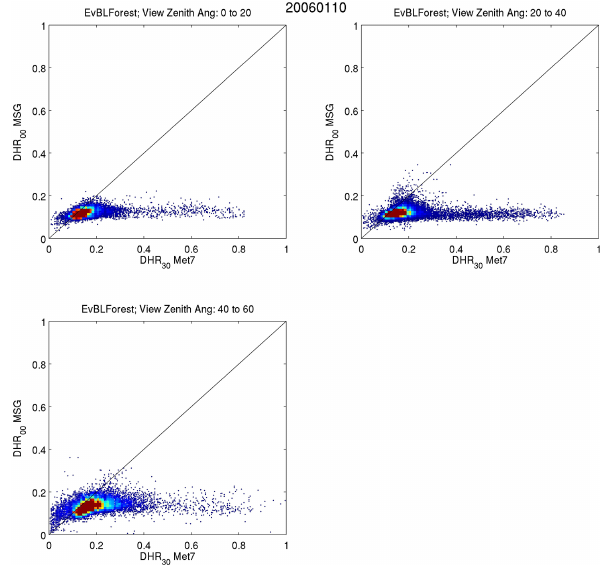
Figure 7. Same as Fig. 6 but for pixels classified as evergreen broadleaf forest. The impact of undetected cloud for the MSA CDR is clearly represented by the tail of high albedo values.